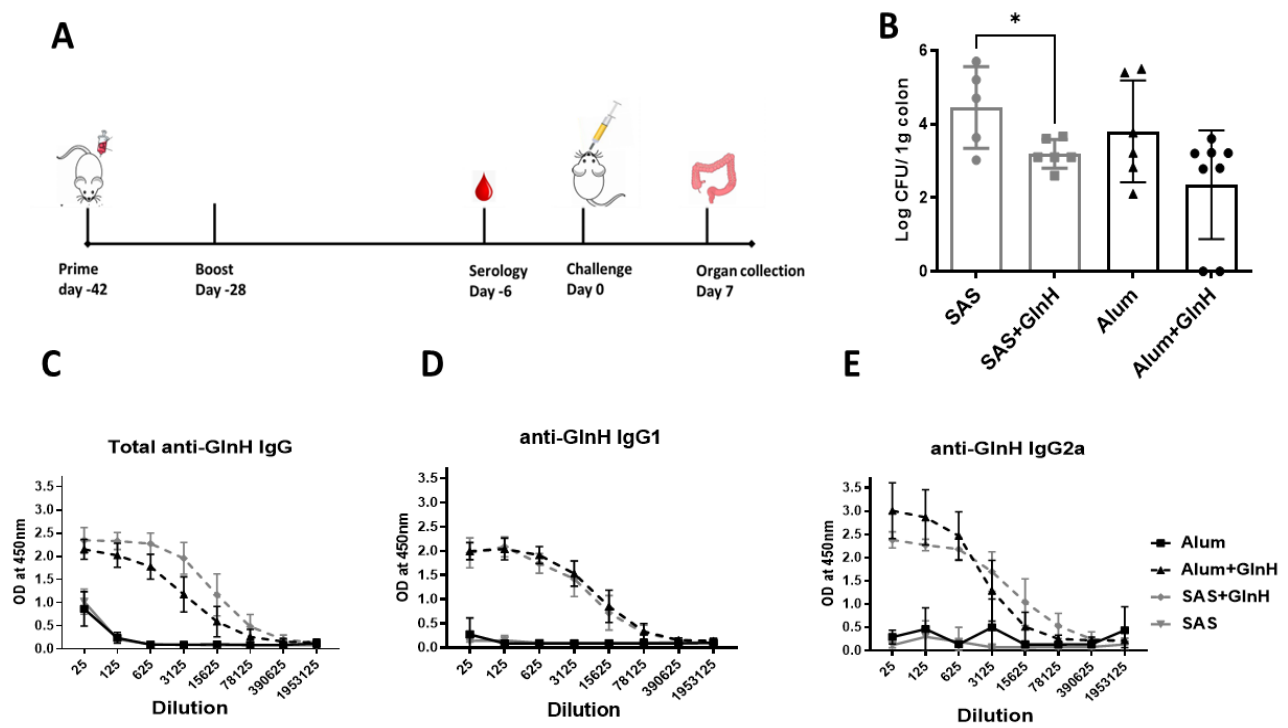
Figure 5. ( A ) Timeline of vaccination schedule, indicating days of immunisation, challenge and or- gan collection. Mice were immunised twice with 10 µg recombinant GlnH antigen with alum or SAS as adjuvant. ( B ) Protection of mice from colonisation following immunisation with recombinant GlnH with SAS as adjuvant. Mice were challenged by oral gavage with 4 × 10 9 CFU E. coli prototype strain NCTC 12900 Nal r , and the colons including caeca were collected from each mouse after eu- thanasia. Bacterial burden was determined per gram of tissue, and level of colonisation was plotted in log scale. All colonisation data are displayed as means ± standard errors of the mean (SEM) of results obtained per treatment group. * Significant difference of NCTC 12900 Nal r colonisation in the GI tract of mice ( p = 0.028). ( C – E ): GlnH-specific total IgG ( C ), IgG1 ( D ) and IgG2a ( E ) responses were measured in mice immunised twice with 10 µg GlnH in the presence of either SAS or alum and compared with respective adjuvant-only groups by indirect ELISA. Sera were obtained by blood collection 28 days after second immunisation dose. 4. Discussion To date, vaccine development against VTEC has been limited to a relatively small number of virulence factors that tend to be subtype specific and predominately focus on the production of high levels of antibodies (Th2 humoral response) to confer protection [15,16]. Bacterial proteins involved in host cell attachment make good vaccine candidates; thus, we aimed to identify previously unidentified proteins in VTEC that are involved in that process. Using a 2D cell blot proteomic approach [34], GlnH was one of several anti- gens identified as being involved in the attachment of the VTEC prototype strain NCTC